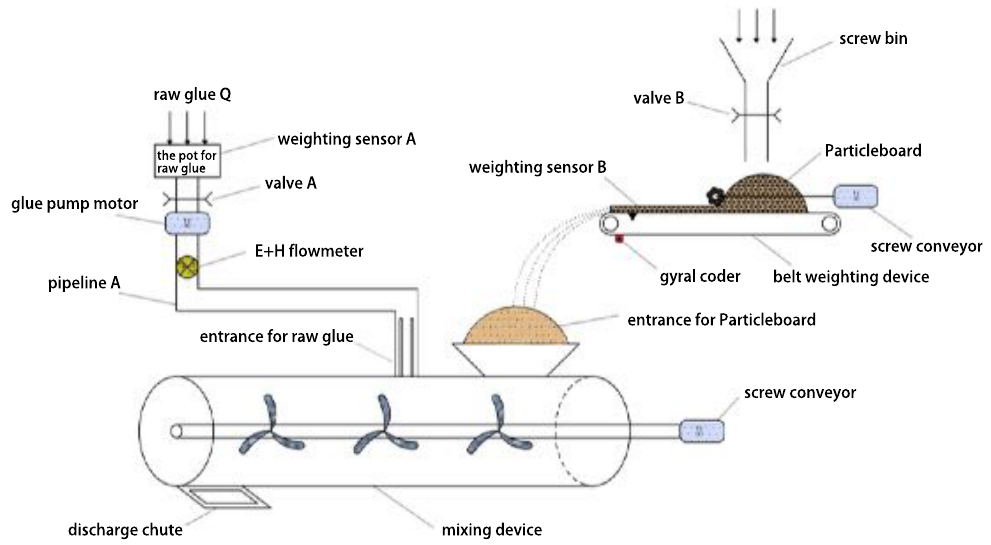
Figure 2. Glue-dosing subprocess of the particleboard glue-dosing